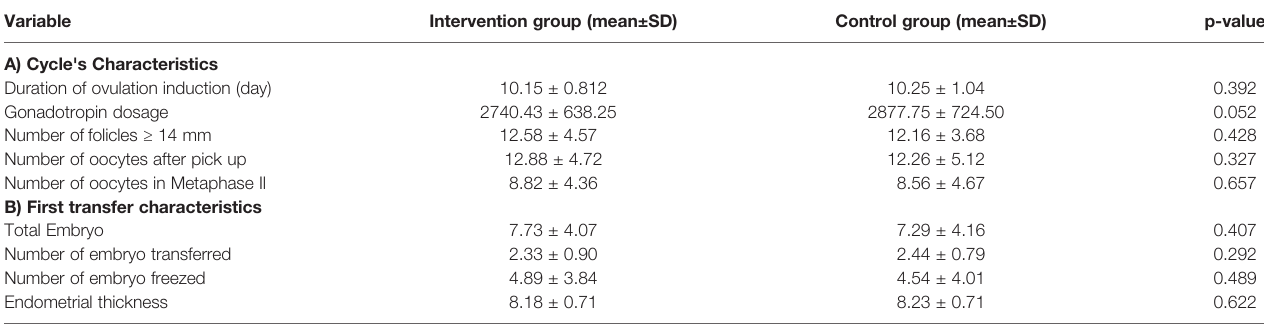
TABLE 2 | A) Cycles ’ characteristics B) fi rst transfer